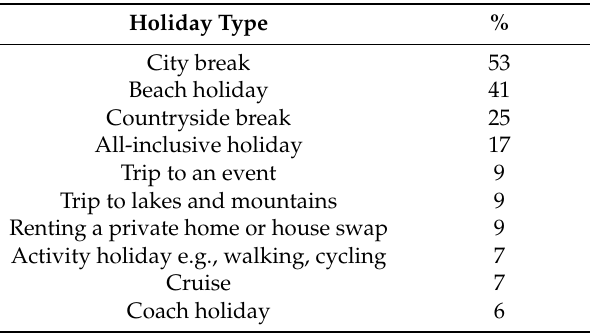
Table 2. The ten most popular types of holiday taken by British people in the 12-month period up to August 2017 [13].